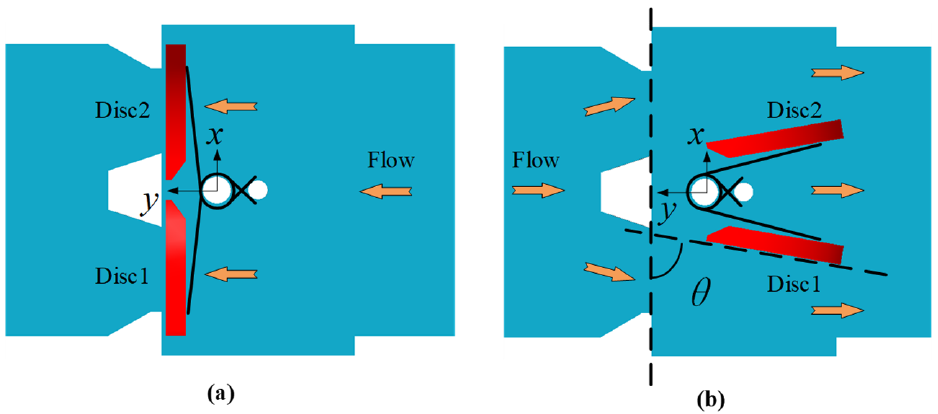
Figure 1. Schematic diagram of the dual disc check valve. ( a ) close valve; ( b ) open valve. When the valve plate is in the fully closed position, the artificial gap between the valve seat and the valve plate appends to ensure the continuity of the calculating flow domain. The volume meshes at this gap become a porous medium, which can almost prevent fluid flow